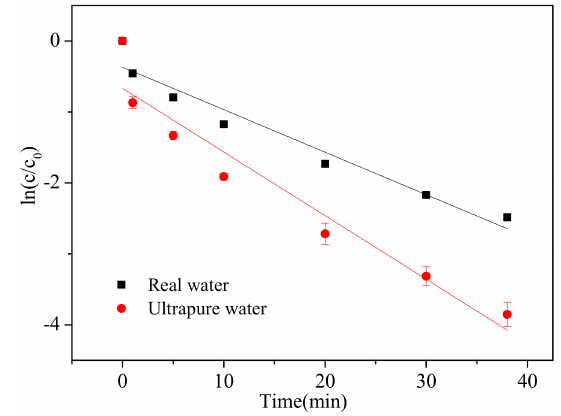
Figure 6. AML degradation by the UV / chlorine process ([AML] 0 = 10 µ M, [chlorine] 0 = 30 µ M, UV intensity = 500 µ W · cm − 2 , pH =